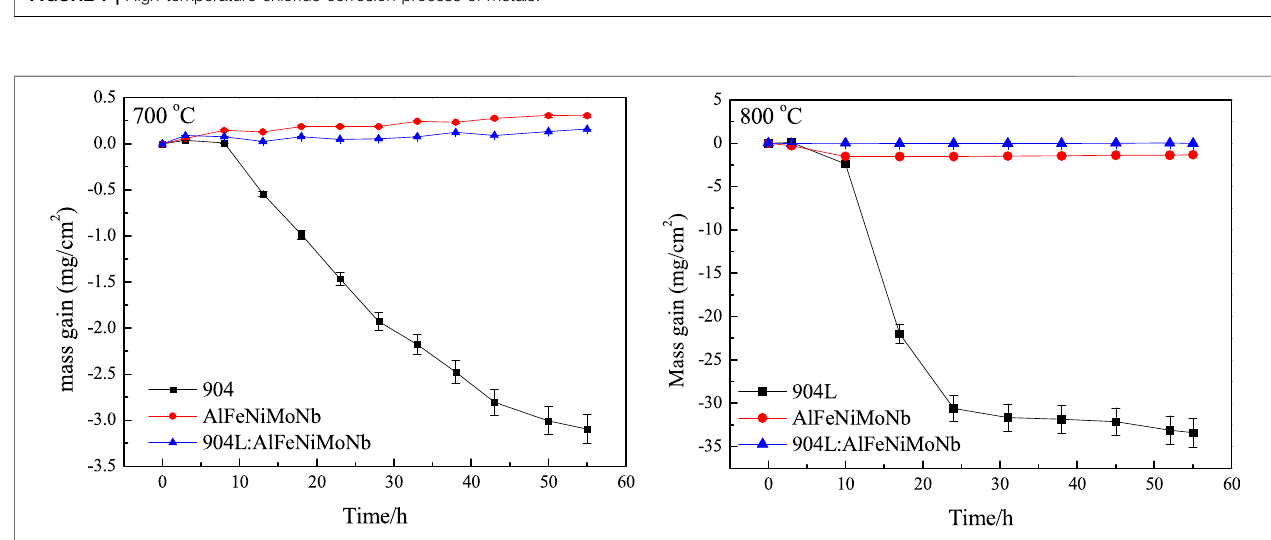
FIGURE 8 | Thermo-gravimetric results for the high-temperature chloride corrosion of alloys at 700 ° C and 800 ° C for 55 h under N 2 – 2.6 vol.% CO 2 – 1.3 vol.% O 2 – 2,700 vppm HCl gaseous